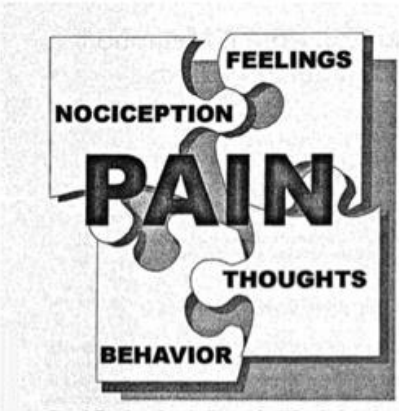
Figure 5. The pain puzzle visual metaphor. Reprinted from Rapoff, M.A.; Lindsley, C.B. The pain puzzle: A visual and conceptual metaphor for understanding and treating pain in pediatric rheumatic disease [59].